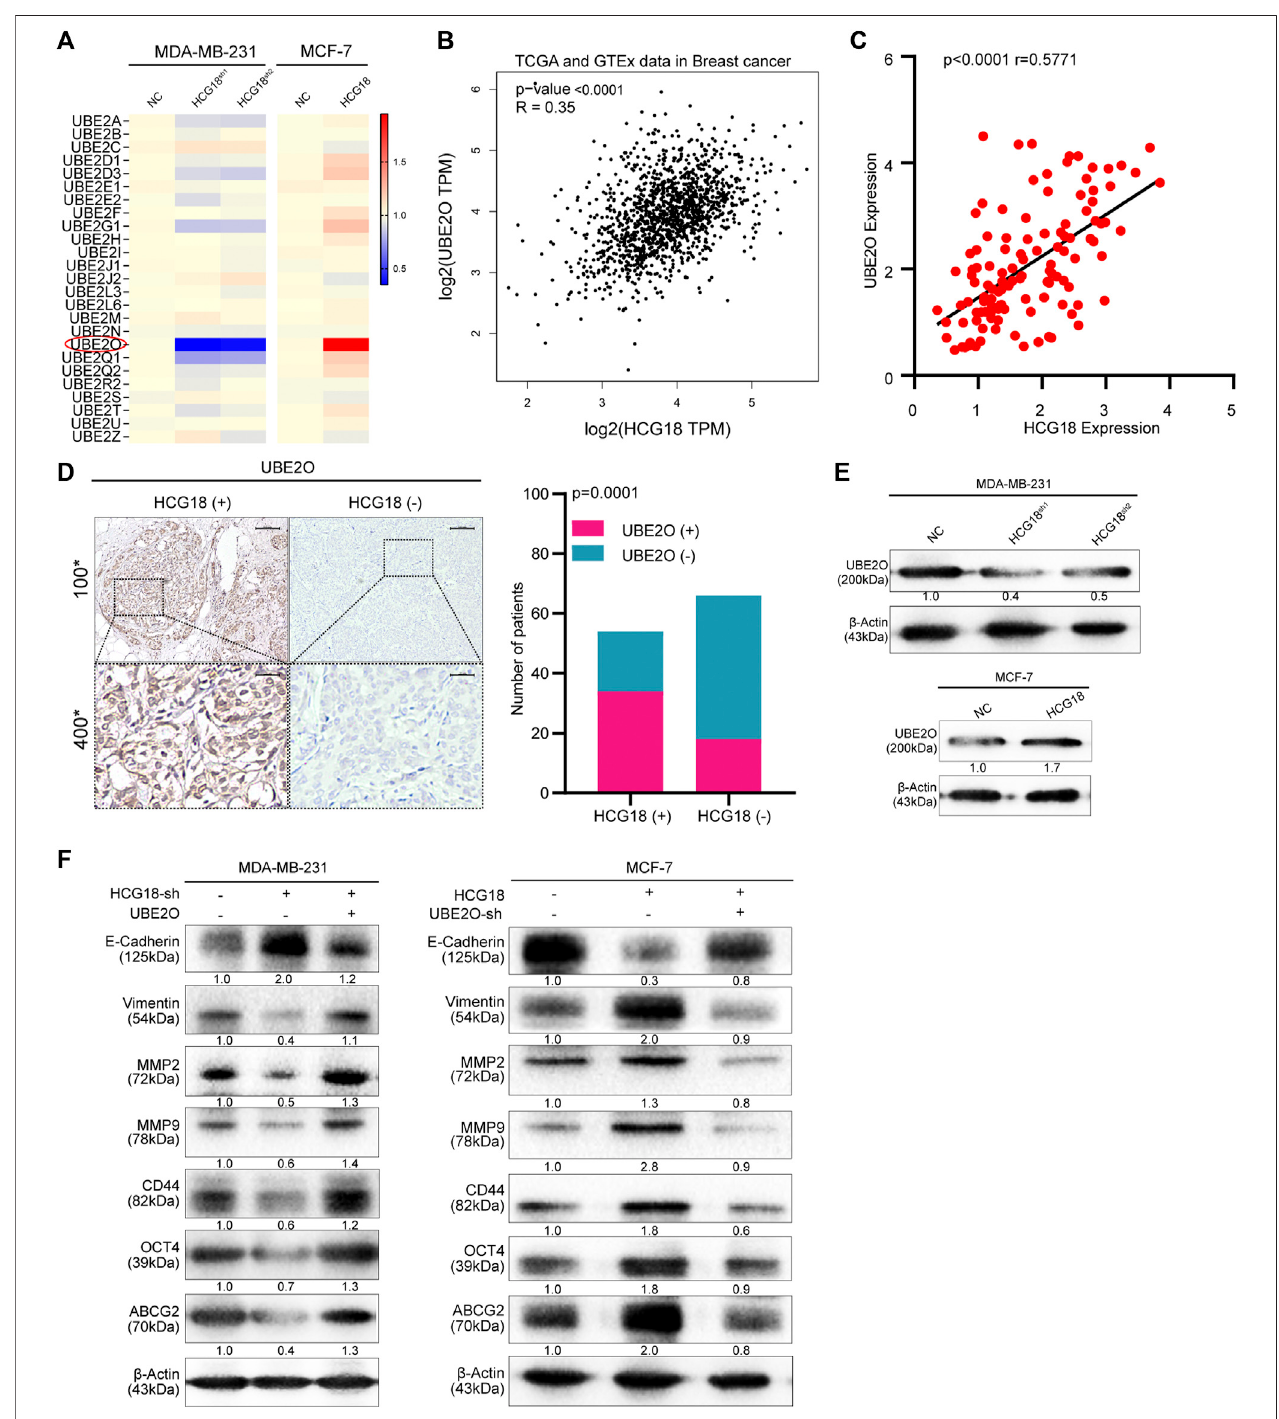
FIGURE 4 | (A) The expression levels of the predicted tumor-related E2s targeting HCG18 were analyzed in MDA-MB-231 NC /MDA-MB-231 HCG18-sh and MCF-7 NC /MCF-7 HCG18 cells. (B) Result from the GEPIA database indicated that UBE2O expression was positively correlated with HCG18 expression in BC. (C) The expressionlevelofUBE2OinBCpatientswasdetectedbyqRT-PCR,andPearsoncorrelationanalysiswasusedtodetecttherelationshipbetweenUBE2OandHCG18 in BC patients. (D) The protein expression level of UBE2O was detected by IHC in BC tissues (the staining results were evaluated with the H-SCORE system, and the mean value was used to distinguish high or low UBE2O expression status; upper: magni fi cation × 100; scale bar, 100 μ m; lower: magni fi cation × 400; scale bar, 20 μ m);itscorrelationwithHCG18wasanalyzedbythe χ 2 test. (E) WesternblottingassayswereusedtodetectUBE2OexpressionafterchangingHCG18expressionin the indicated cells. (F) We overexpressed UBE2O in MDA-MB-231 HCG18-sh cells (generating MDA-MB-231 HCG18-sh+UBE2O cells) and reducing UBE2O in MCF-7 HCG18 cells(generatingMCF-7 HCG18+UBE2O − sh cells).Then,WesternblottingassayswereperformedtoexaminethechangesintheexpressionofEMTmarkers(E-cadherinand vimentin), metastatic markers (MMP-2 and MMP-9), and CSP markers (CD44, OCT4, and ABCG2) in the indicated cells. The data are shown as the mean ± SD. * p < 0.05, ** p < 0.01, *** p < 0.001. The data represent at least three independent experiments. Frontiers in Cell and Developmental Biology |